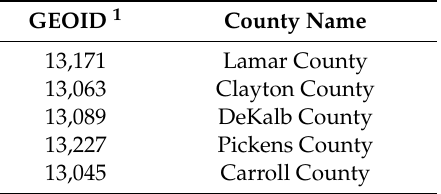
Table A1. U.S. counties that are included in Metro